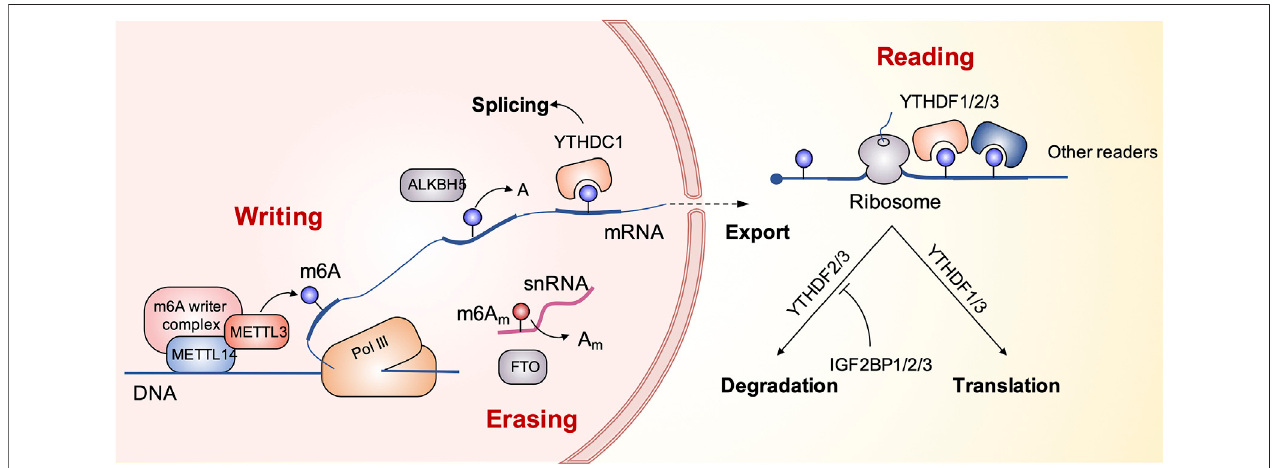
FIGURE 1 | The schematic diagram presents the biological process of m6A modi fi cation.